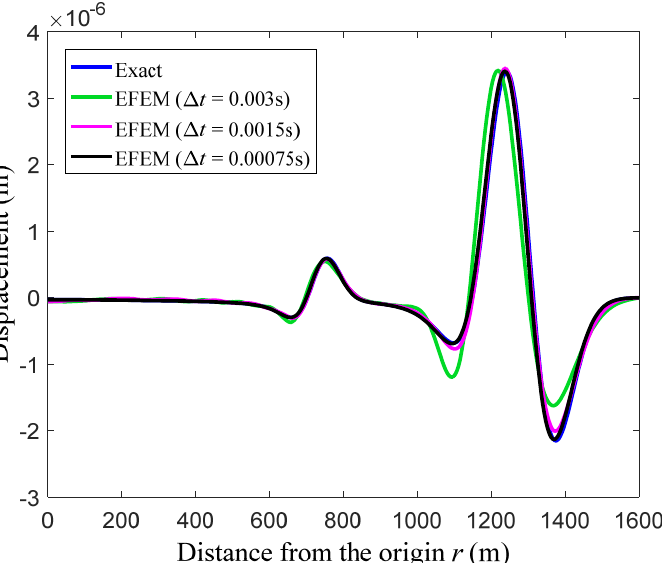
Figure 5. The calculated displacement solutions from the present EFEM along the y -axis at observation time t = 0.5 s.